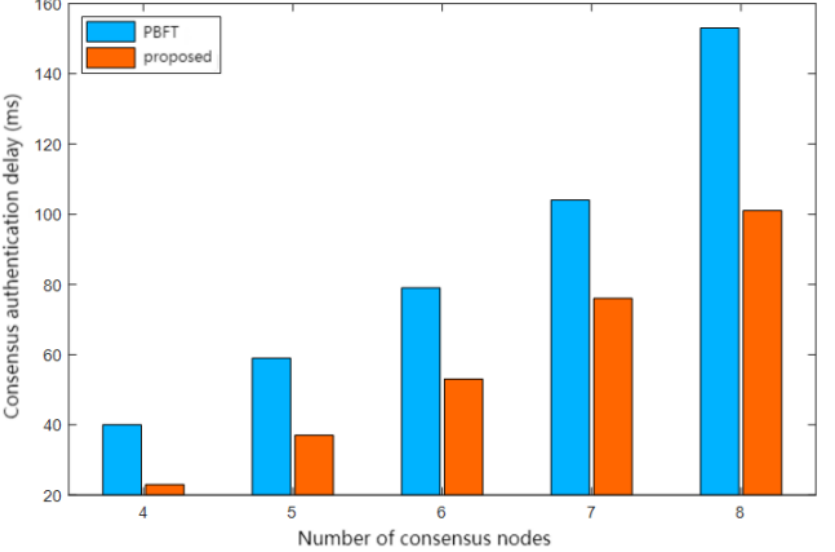
Figure 10. Comparison of efficiency between consensus algorithms.